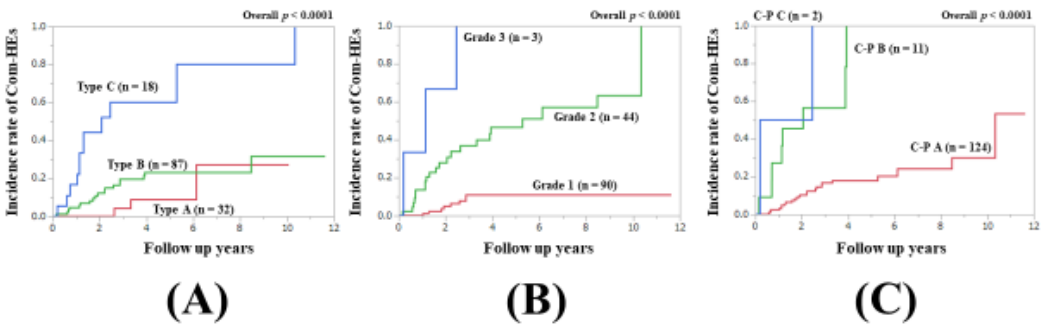
Figure 5. Cumulative incidence rates of composite hepatic events in patients with FIB4 index <4.46 (median value in our cohort, n = 137). ( A ) Serum Zn level grading system. ( B ) ALBI grading system. ( C ) Child–Pugh classification.